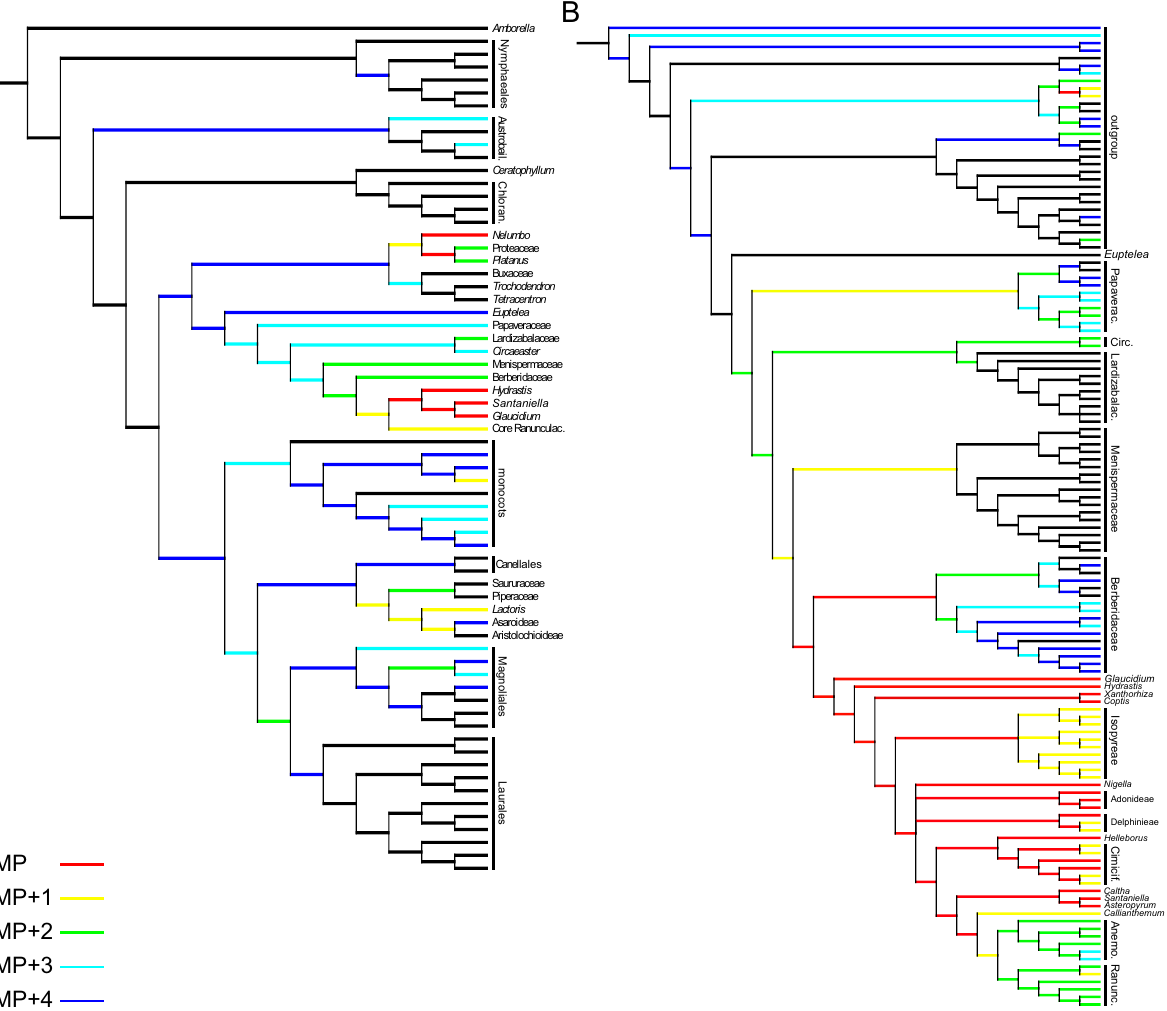
Figure 6. Phylogenetic position of Santaniella gen. nov. Most parsimonious positions of Santaniella after its addition to the matrix of Kvaček et al. 40 in ( A ) and Wang et al. 45 in ( B ). Colour scale indicates all most parsimonious positions in red (MP), and those one step less parsimonious in yellow (MP + 1), two steps less parsimonious in green (MP + 2), three steps less parsimonious in cyan (MP + 3), and four steps less parsimonious in dark blue (MP + 4)